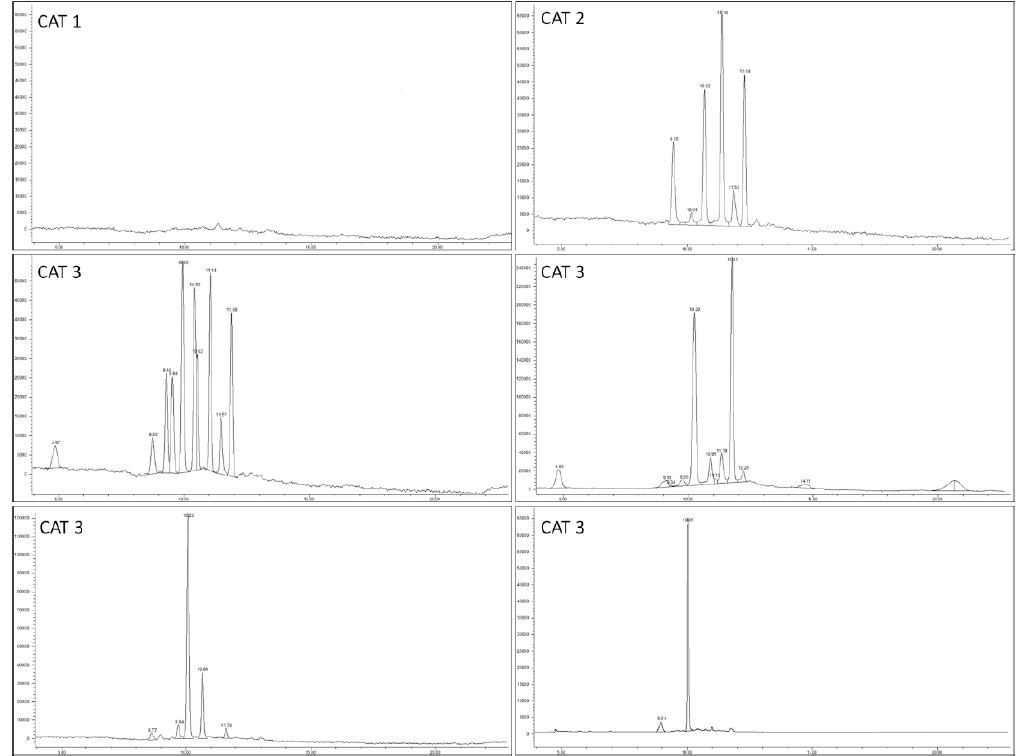
Figure 1. Representative chromatograms of the three main categories into which the 24 Vaccinium macrocarpon -based dietary supplements were grouped. CAT 1 groups the products that showed a flat chromatogram, indicating not only the absence of Vaccinium macrocarpon , but also of any other fruit containing anthocyanins; CAT 2 groups the products that showed a chromatogram typical of Vaccinium macrocarpon fruits; CAT 3 groups the products that contained anthocyanins not characteristic of Vaccinium macrocarpon . Table 3. Quantification of total anthocyanin content (TAC) and chemical fingerprinting of the 24 Vaccinium macrocarpon -based dietary supplements. Results are the mean of three di ff erent replicates, and they are expressed as mg of cyanidine chloride equivalent ± SD. The di ff erent supplements are grouped in three di ff erent categories in the column “CAT”, depending on the di ff erent chromatogram recorded at λ = 520 nm (see Figure 1). The non-typical anthocyanins found in each sample are reported in the column “UHPLC-Orbitrap”. (D3Ru = delphinidin-rutinoside; D3Gl =